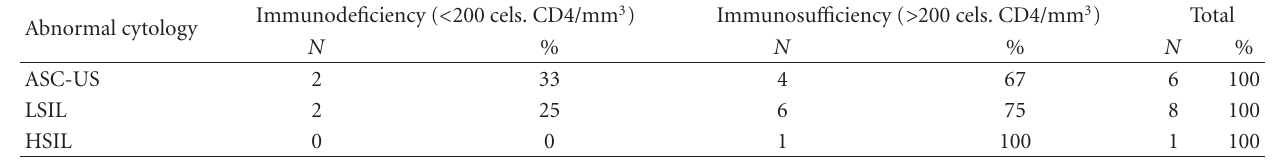
Table 2: Frequency of abnormal cytology correlated with immunological status in the HIV-positive women. Abnormal cytology